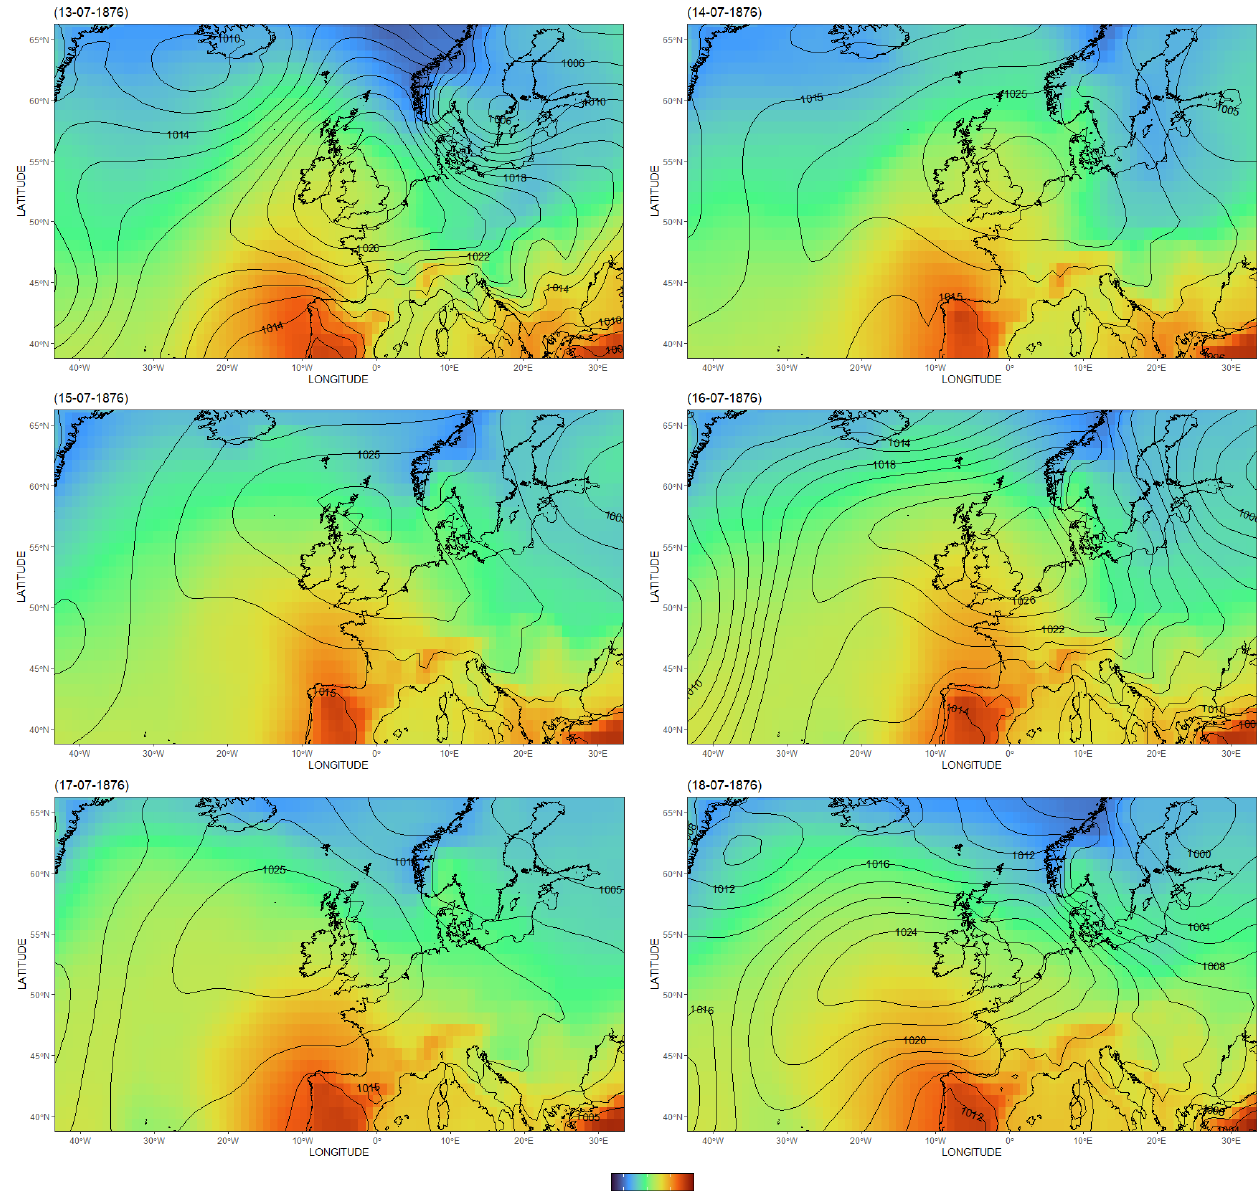
Figure 9. NOAA 20CRv3 MSLP and 850hPa temperatures evolution around the Phoenix Park observed value of 33.5 ◦ C in 1876 on 16 July. The 20th Century Reanalysis V3 data provided by the NOAA/OAR/ESRL PSL, Boulder, Colorado, USA, from their web site at https://psl.noaa.gov/data/gridded/data.20thC_ReanV3.html (last access: 21 January 2022). The domain of latitude 35–70 ◦ N and longitude 45 ◦ W–30 ◦ E was chosen to provide a synoptic view, with Ireland centred to provide an overview of the surrounding regions. All maps correspond to 15:00UTC, which is the approximate expected time of daily maxima in Ireland (corresponding to ca.